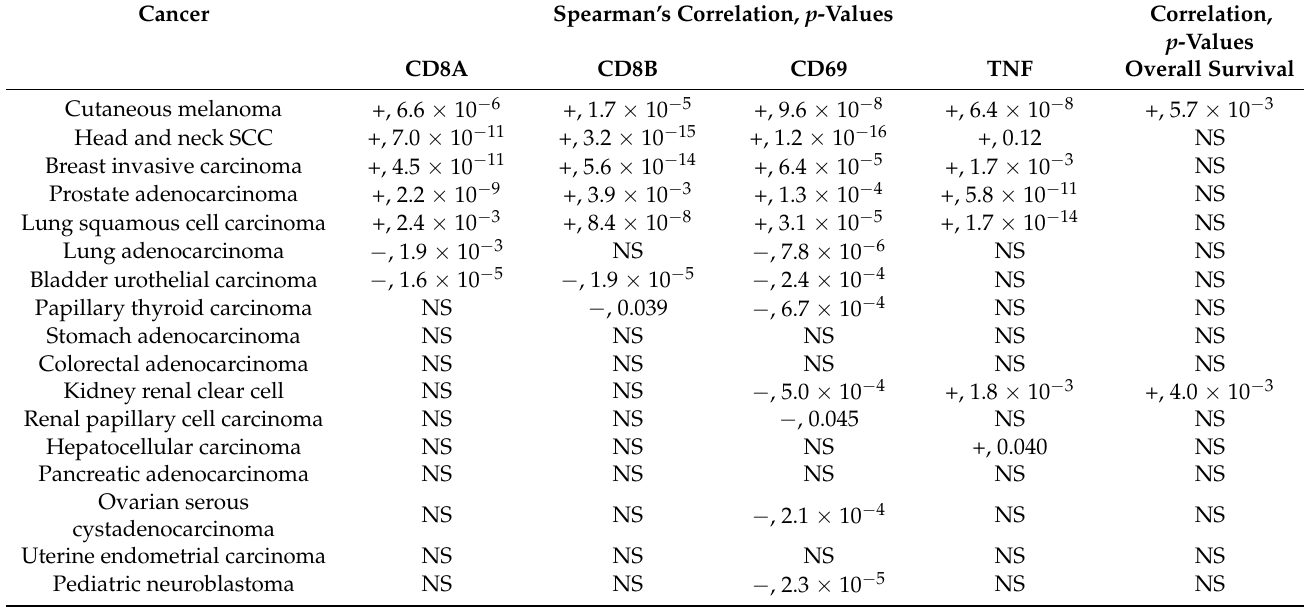
Table 2. MYCN mRNA correlations with mRNA expression for CD8 T cell and activation markers and overall survival in TCGA cancer